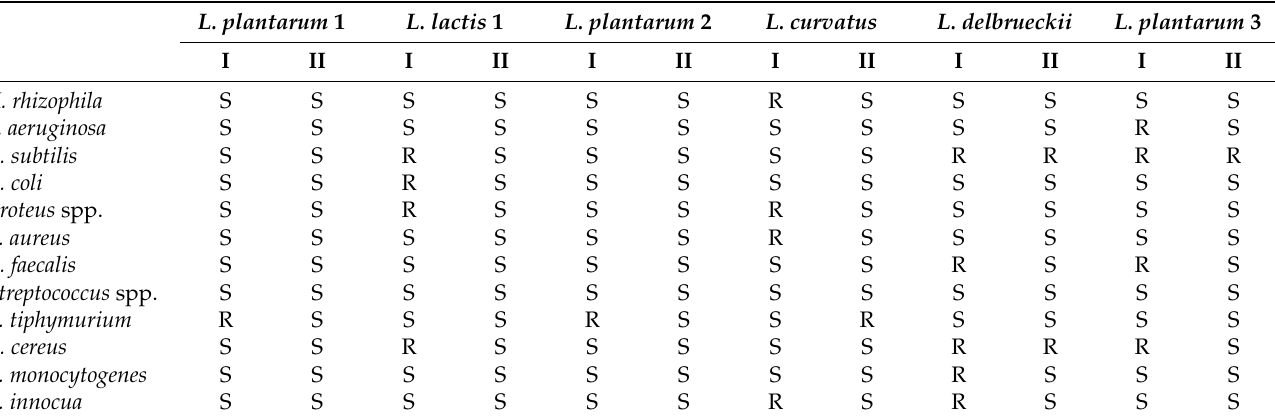
Table 6. Results of the antimicrobial activity for LAB strains.